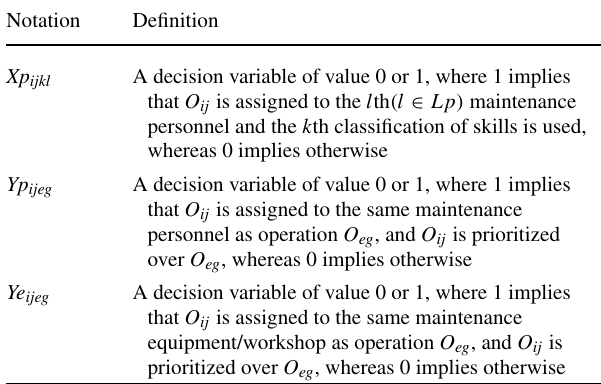
Table 1 Relevant notations used in model of